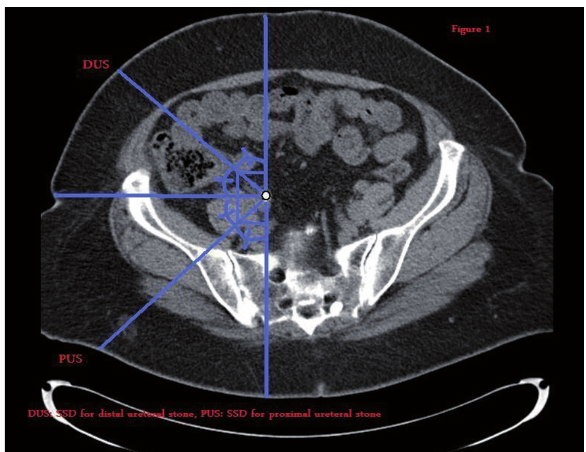
Figure 1 - Showing pathways for ultrasonic